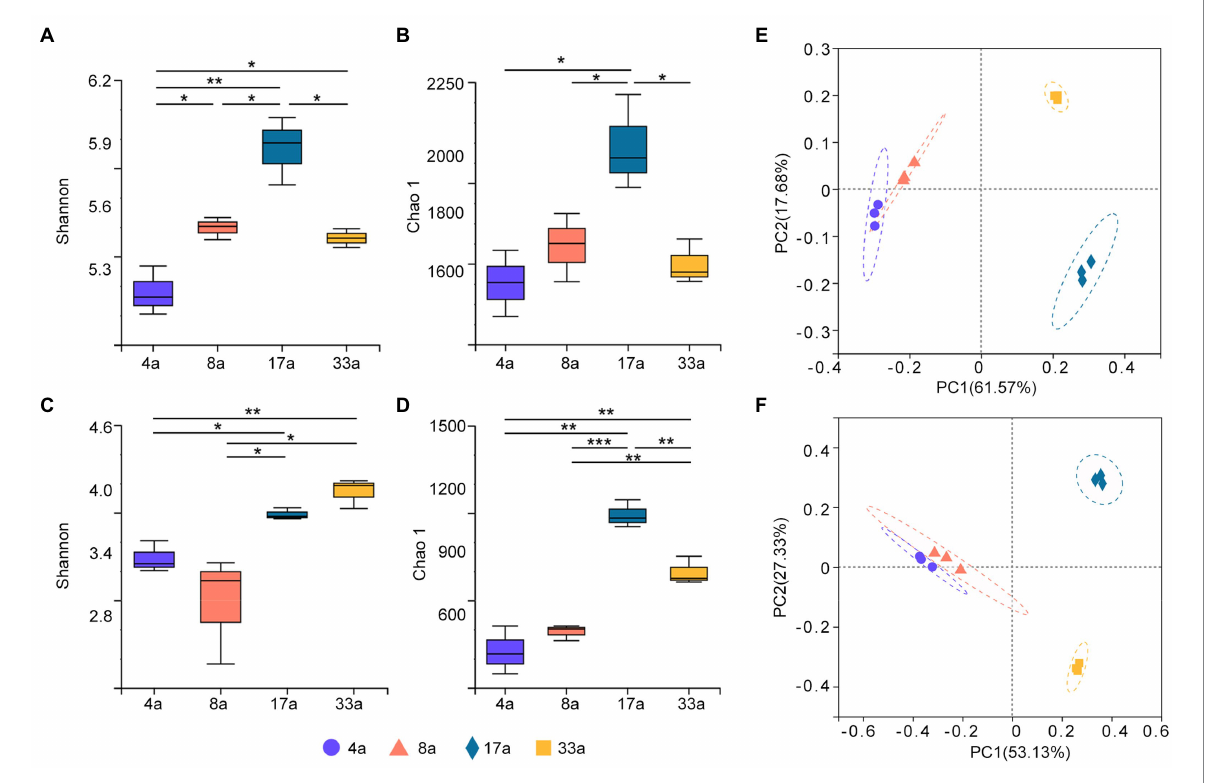
FIGURE 1 Alpha diversity (Shannon and Chao1 indices) of bacteria (A,B) and fungi (C,D) in the rhizosphere of blueberry at different ages. Significant differences between the 4a, 8a, 17a, and 33a sites are indicated in each figure panel (* p < 0.05, ** p < 0.01, and *** p < 0.001). Principal co-ordinates analysis (PCoA) analysis of bacteria (E) and fungi (F) in the rhizosphere microbial communities of blueberry at different ages based on Bray–Curtis distance metrics.